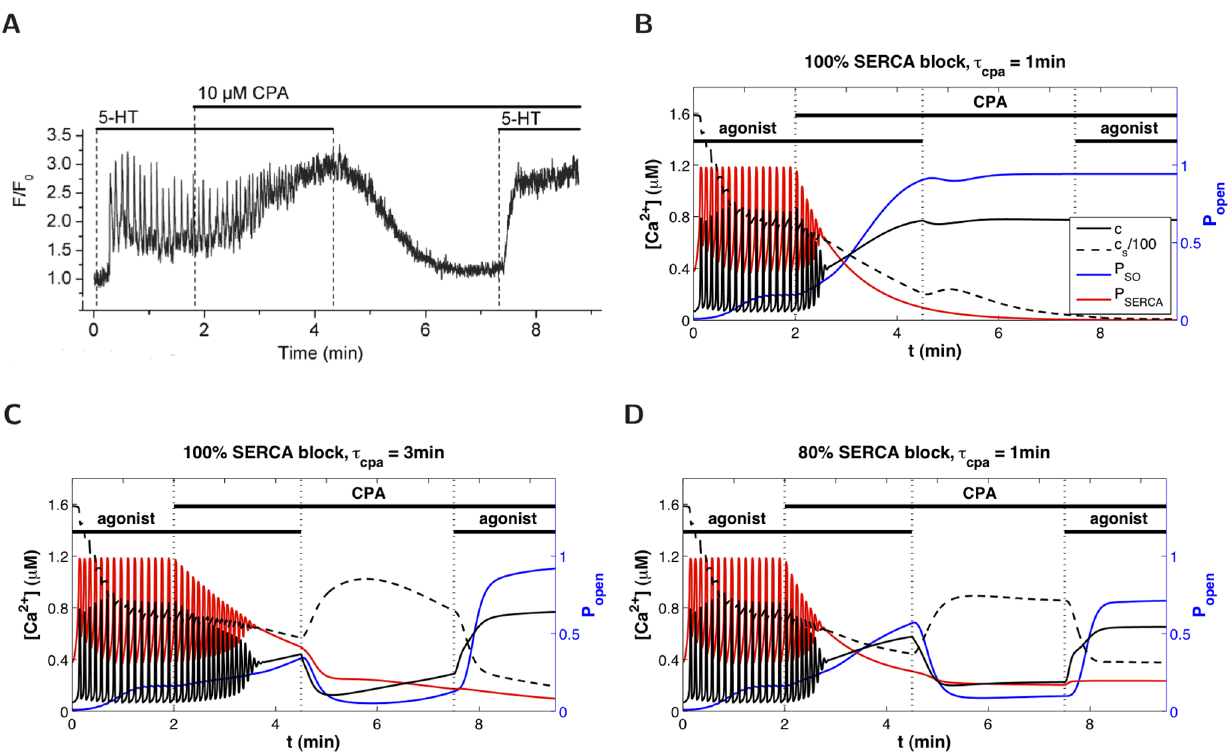
in ASMC of a mouse lung slice treated with agonist and CPA. Figure 6. Effect of CPA on ½ Ca 2 z (cid:2) dynamics. (A) Fluorescence imaging of ½ Ca 2 z (cid:2) i i decrease. (B–D) Model simulations of the experiments shown in (A), assuming that (B) CPA quickly blocks the Agonist removal leads to ½ Ca 2 z (cid:2) i SERCA, (C) CPA slowly blocks the SERCA, (D) CPA partially blocks the SERCA but reaches maximum strength rather quickly. Black solid and dashed and ½ Ca 2 z (cid:2) ; blue and red curves (right y-axis) show respectively the fraction of open SOCC and curves (left y-axis) represent respectively ½ Ca 2 z (cid:2) i SR the fraction of operating SERCA (that is, P SERCA ~ J SERCA = V e , where J SERCA is given by Eq.